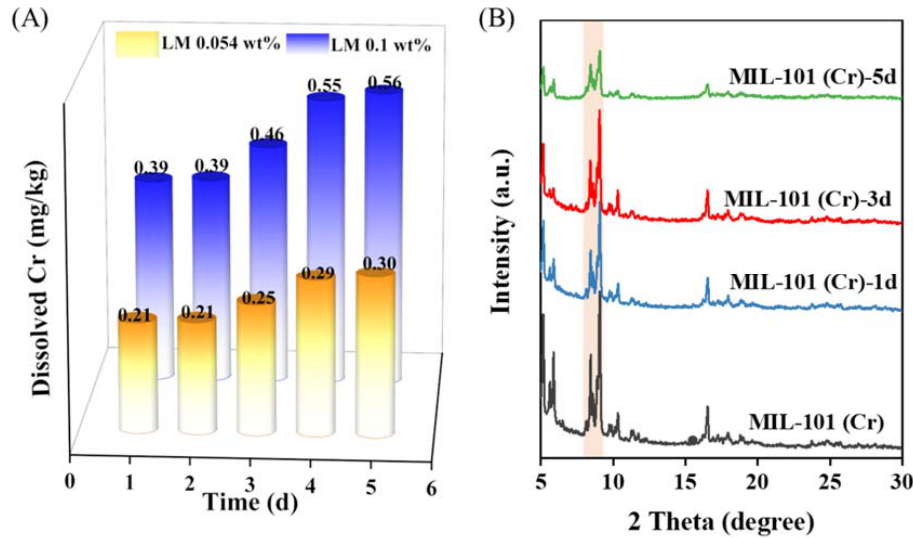
Figure 6. ( A ) Dissolved chromium ion over time when MIL-101(Cr) is dispersed in physiological saline solutions and ( B ) XRD patterns of MIL-101(Cr) soaked in saline solution for different times.